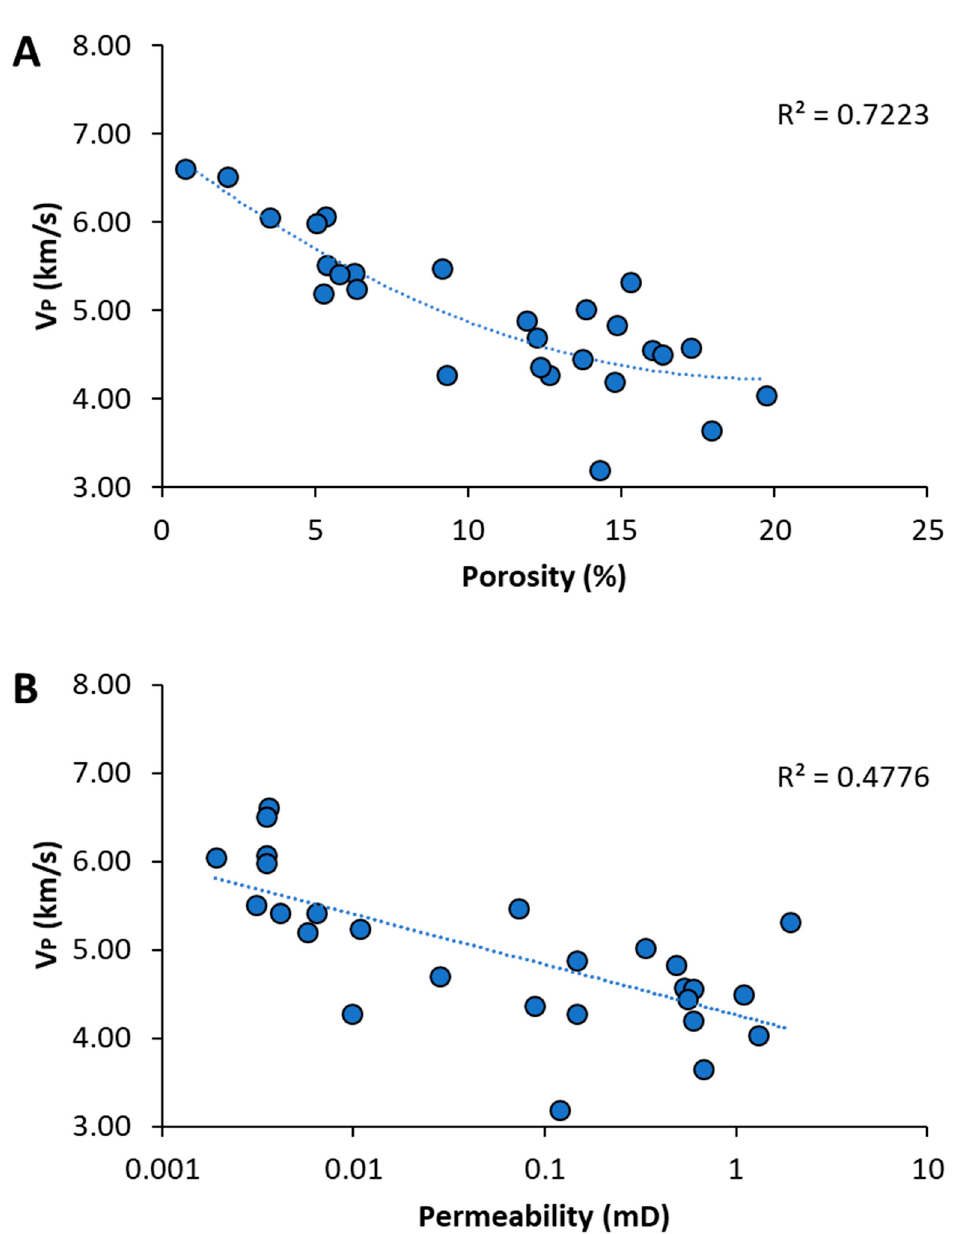
Figure 10. ( A ) Porosity and ( B ) Permeability inverse relation with compressional velocity (V P ). Velocity is more controlled by porosity (R2 = 0.7) than permeability (R2 = 0.5).